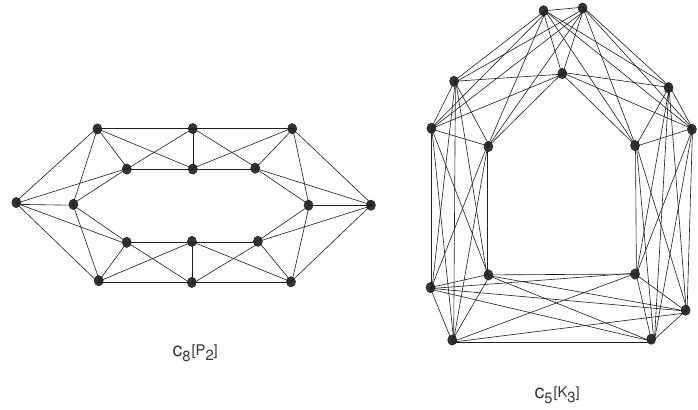
Figure 4. The closed fence graph C 8 [ P 2 ] and Catlin graph C 5 [ K 3 ]